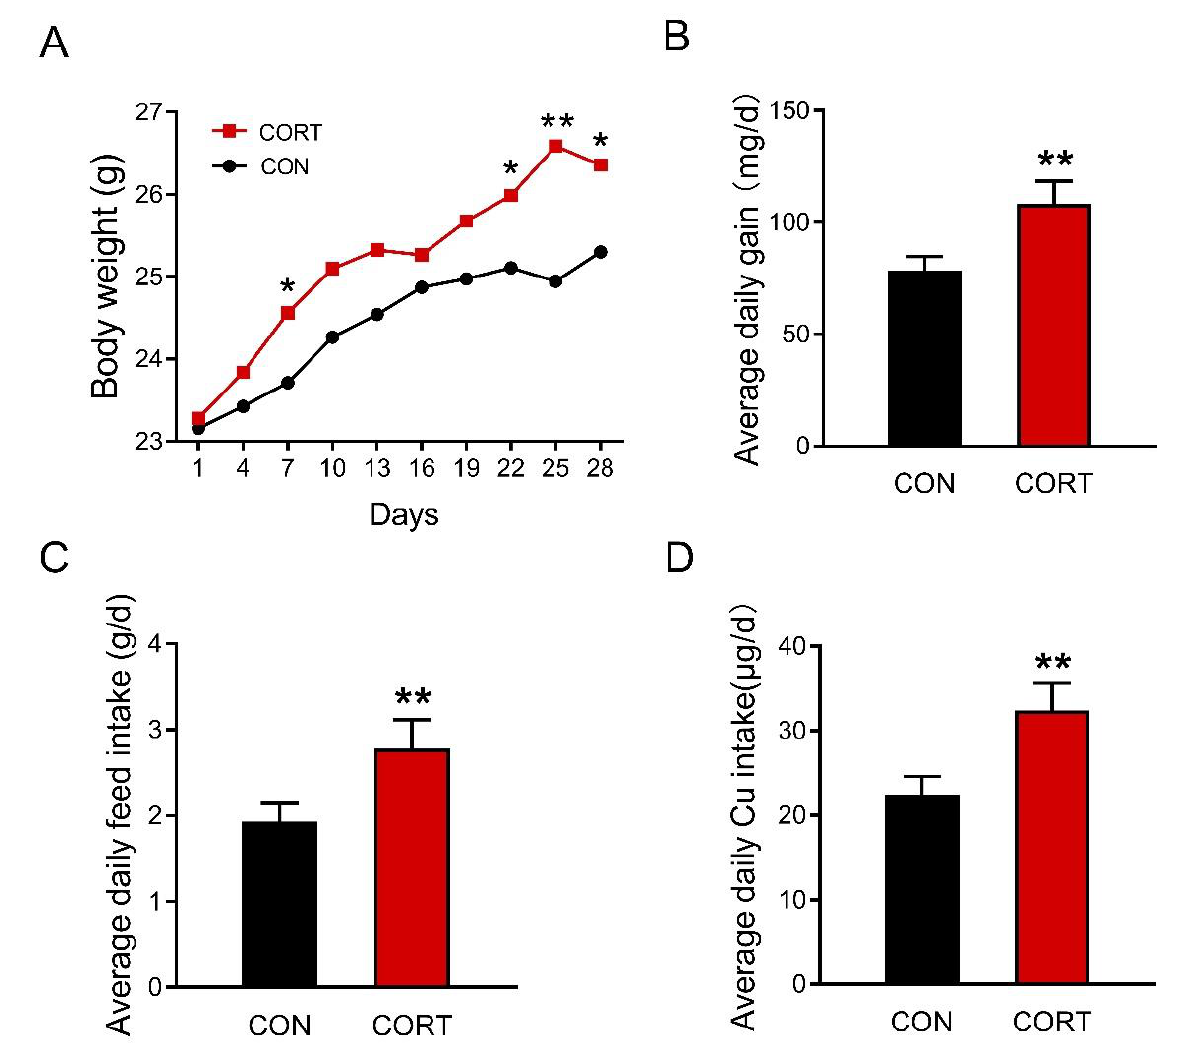
Figure 1. Corticosterone exposure increases average daily food intake and final body weight in mice. ( A ) The change of mouse body weight over time during the experiment (n = 25). ( B ) Average daily feed intake (n = 5). ( C ) Average daily copper intake (n = 5). ( D ) Average daily copper intake (n = 5) . CON = control group; CORT = corticosterone exposure group. Values are means ± SEM, * P < 0.05, ** P < 0.01.